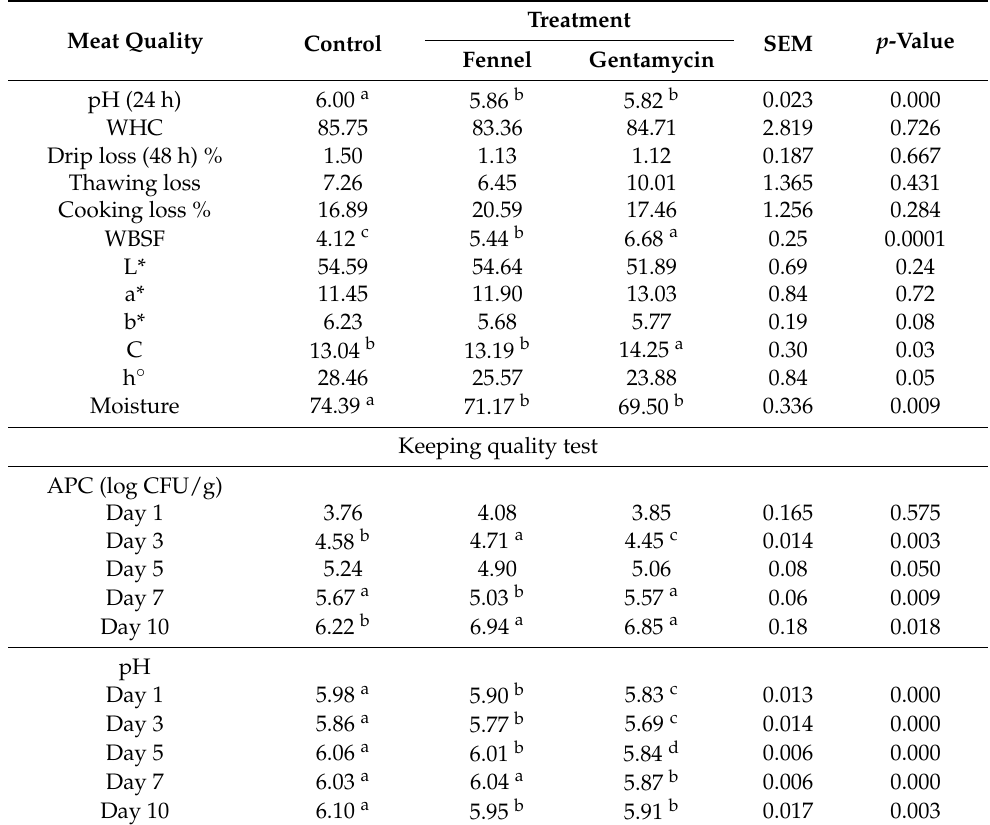
Table 5. Impact of dietary fennel oil or gentamycin on meat quality of weaned Moshtohor rabbits aged 12